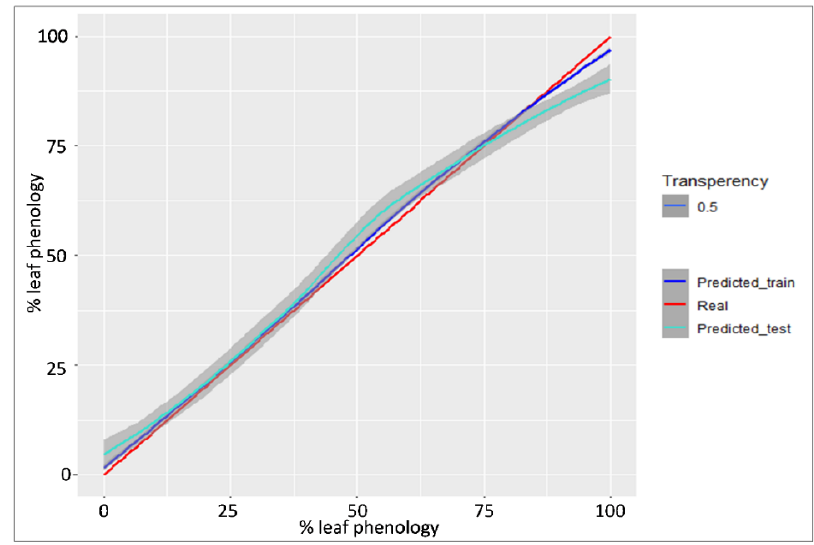
Figure 7. Comparison of actual and predicted data on both training and test datasets.